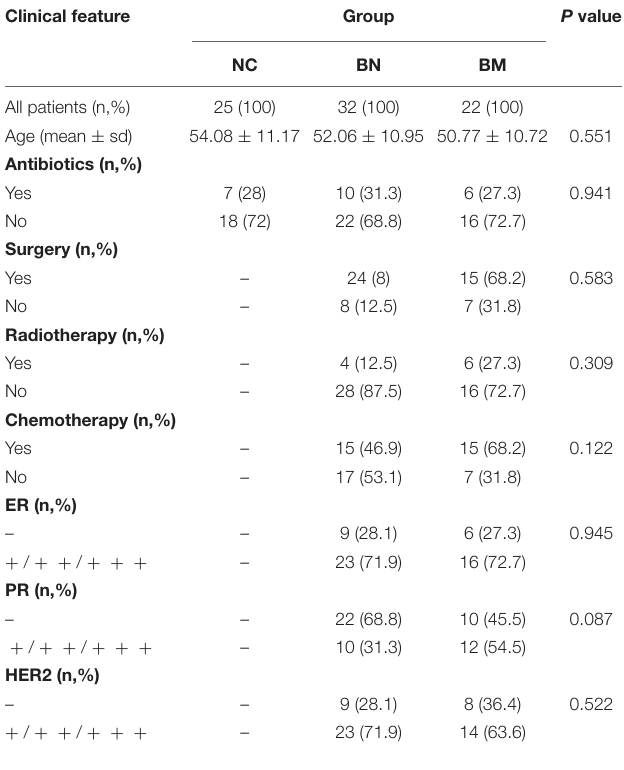
TABLE 1 | Clinical features of normal control and breast cancer patients with or without bone metastasis. Clinical